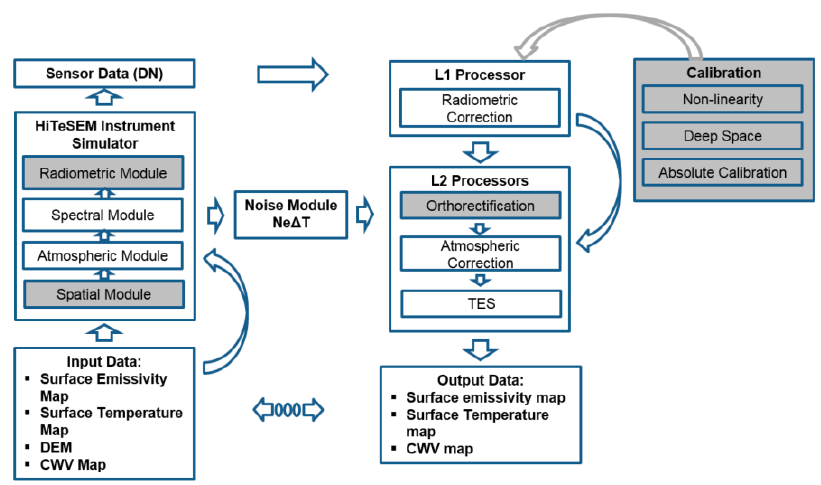
Figure 1 . Flowchart depicting the entire HeteS end-to-end processing chain. Grey-filled modules were not applied in the study.